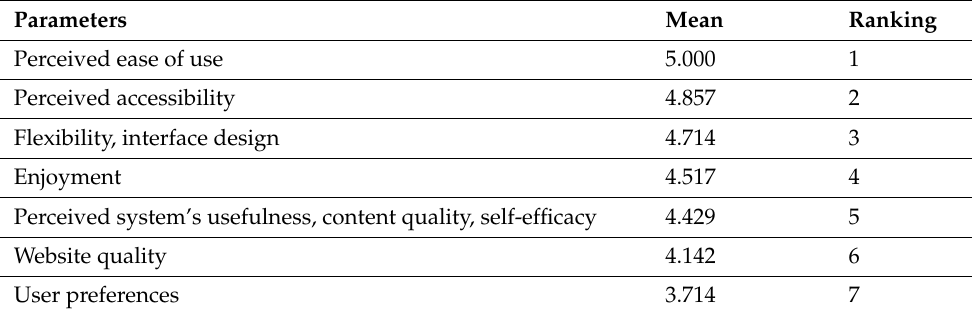
Table 4. Summary of parameters of iteration 3.